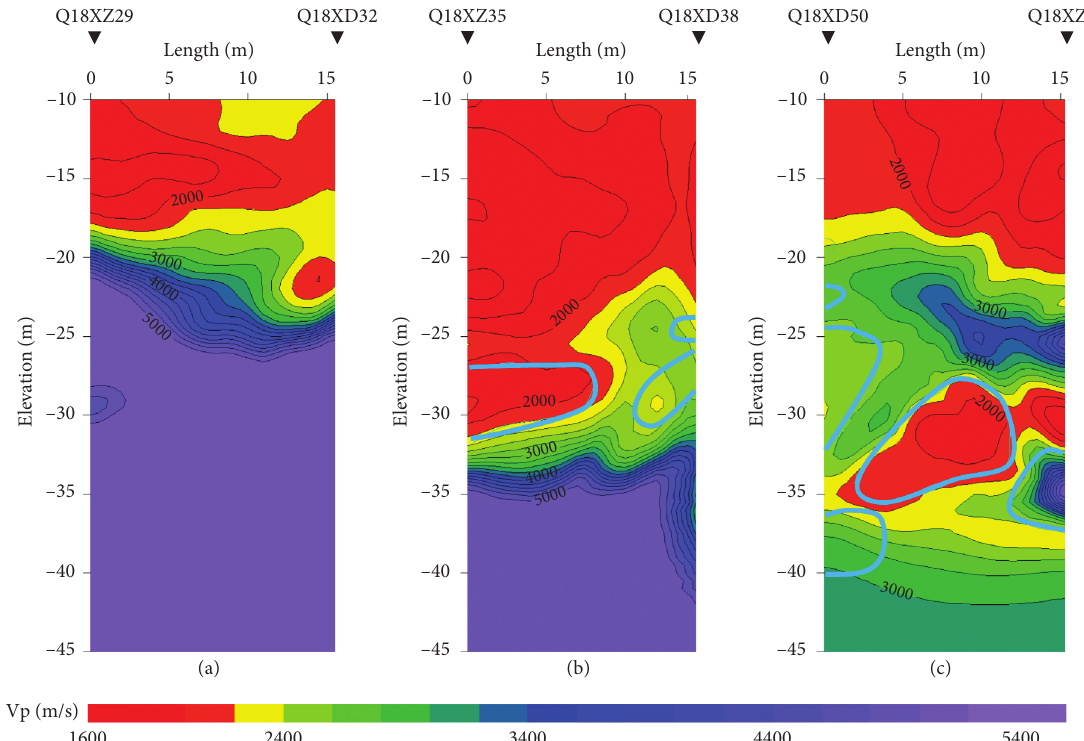
Figure 4: Wave velocity chromatograms of the crosshole seismic CT inversion: (a) without karst profile; (b) karst moderately developed profile; (c) karst strongly developed profile. The blue lines are the interpreted karst caves.